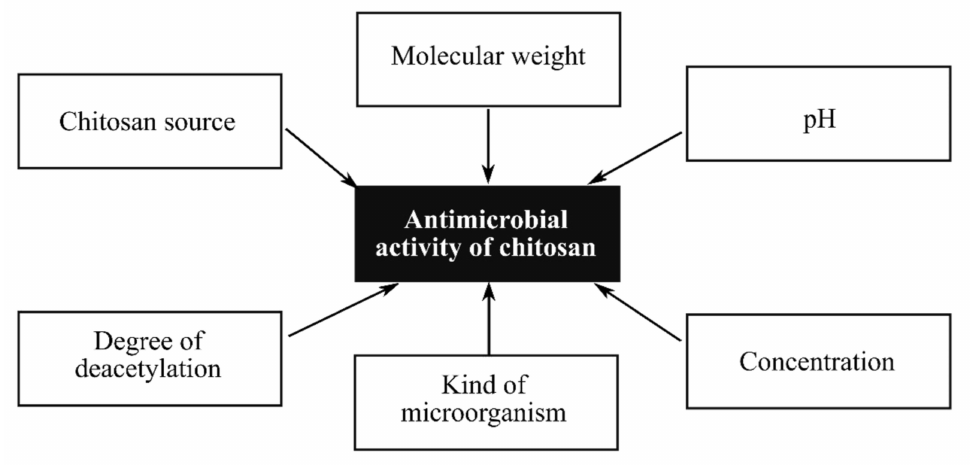
Figure 4. Selected factors influencing the antibacterial activity of chitosan (own